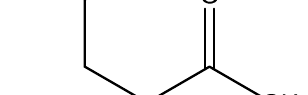
Figure 15. Structural illustration of maleic acid. Molecules 2020 , 25 , x